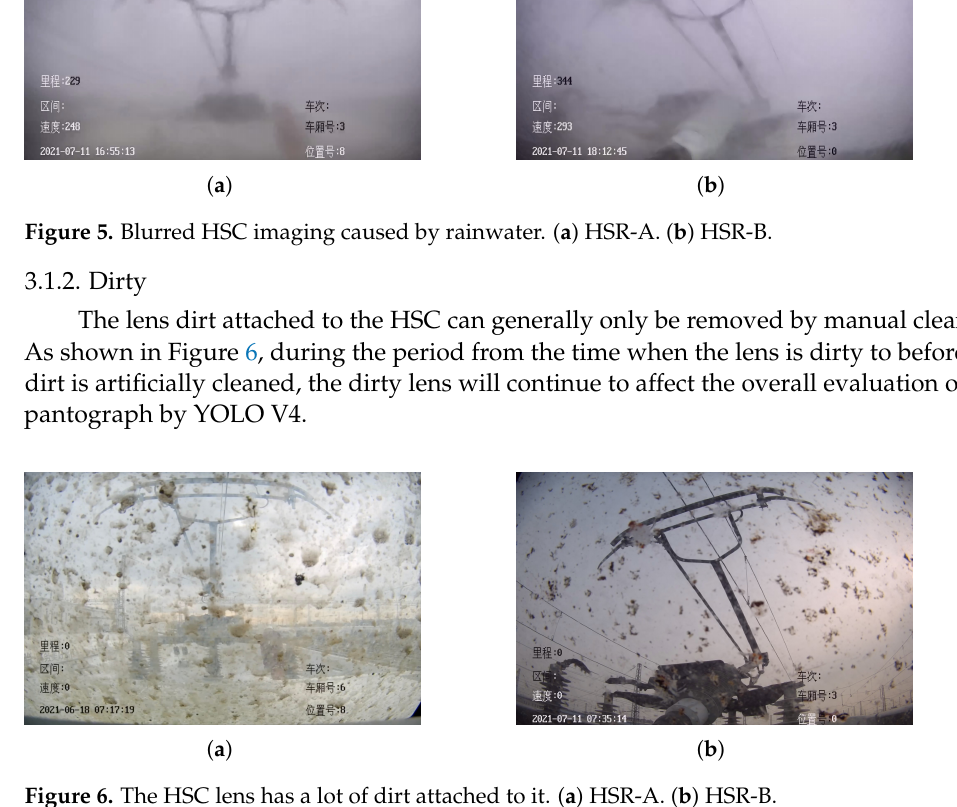
Figure 6. The HSC lens has a lot of dirt attached to it. ( a ) HSR-A. ( b )